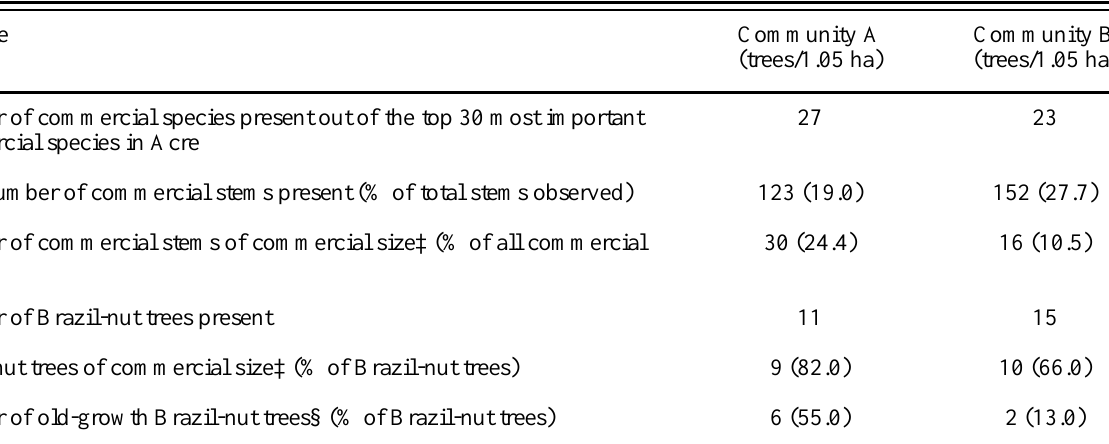
Table 9. Characteristics of commercial tree species and Brazil-nut trees† present in 42 sample plots in the two communities. The total area of the sample plots is 1.05 ha. Mean